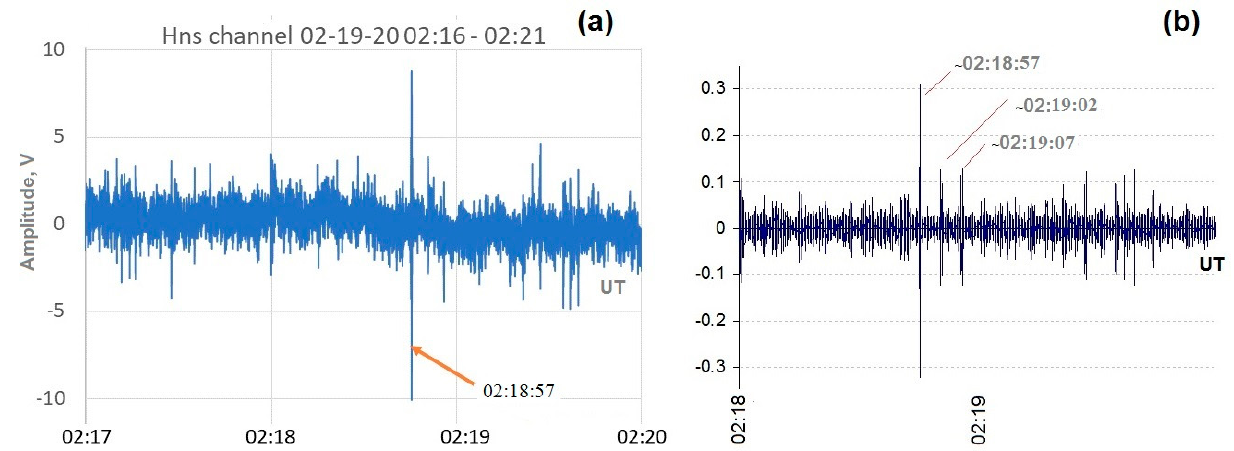
Figure 17. Schumann antenna signal amplitude on 19 February 2020: ( a ) raw time series; ( b ) its second order derivative time series.